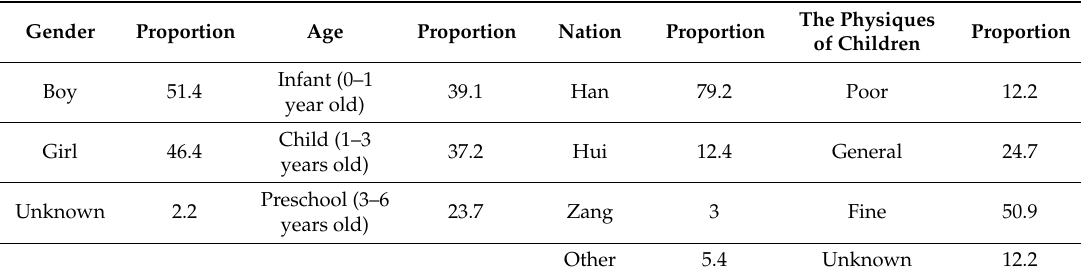
Table 3. The basic situation of